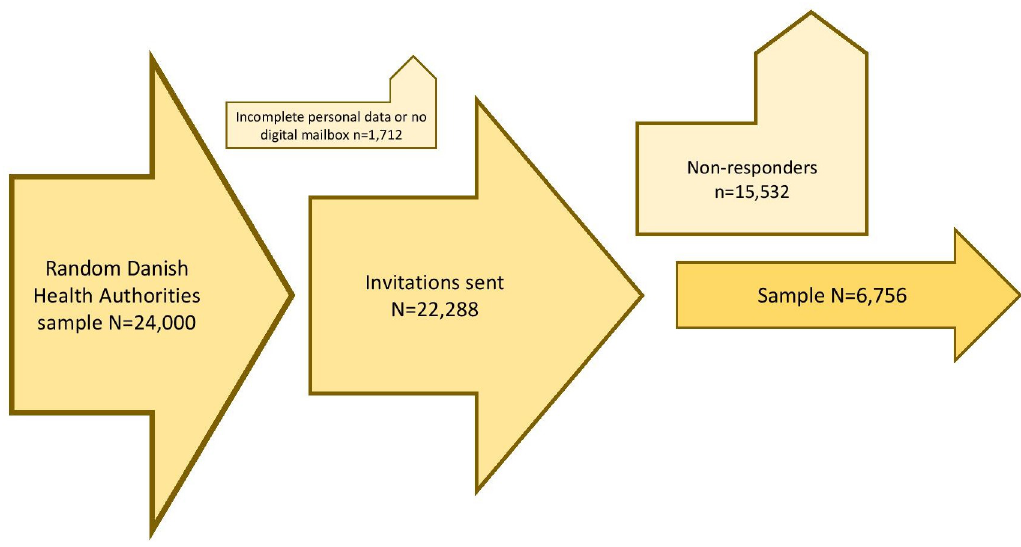
Fig 2. Inclusion of study